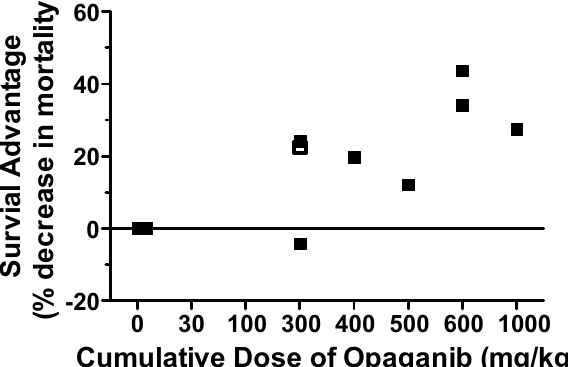
Figure 7. Survival advantage of opaganib when given after radiation exposure. The percent decrease in mortality observed at the indicated cumulative dose of opaganib given 24 h after 16.0 Gy of radiation across multiple experiments are plotted. A single dose of opaganib was given in the experiment indicated by the open symbol ( □ ), whereas all other data derives from multiple dose treatment given over 2, 3 or 5 days following radiation ( ∎ ).